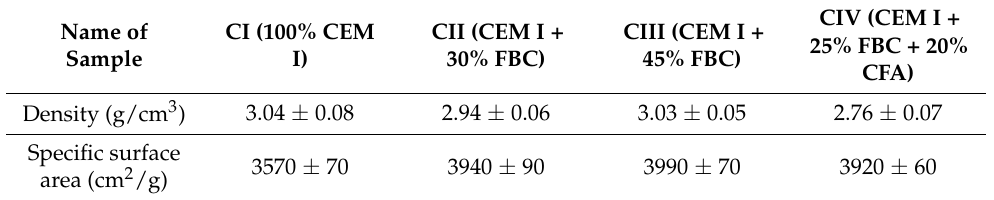
Table 3. Density and surface area of cementitious-fly-ash binders.